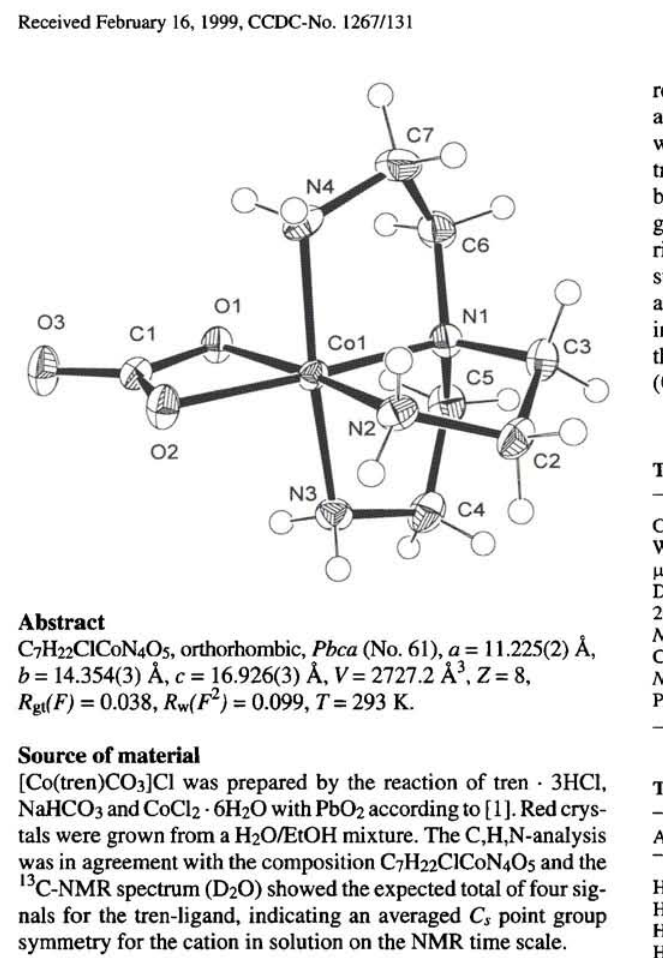
Table 2. Atomic coordinates and displacement parameters (in Â 2